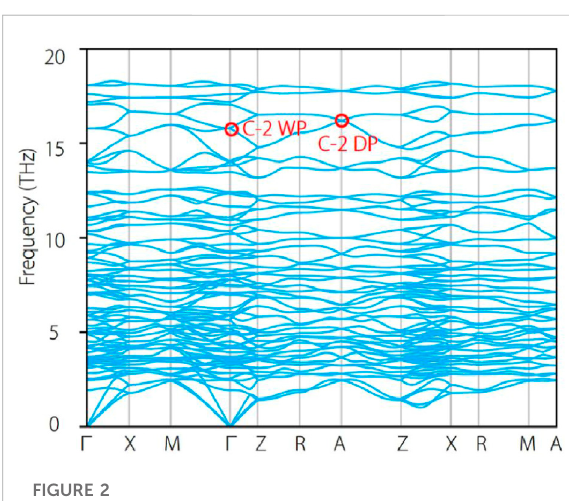
FIGURE 2 PhonondispersionoftetragonalNa 2 Zn 2 O 3 withP4 3 2 1 2along Γ -X-M- Γ -Z-R-A-Z-X-R-M-A high-symmetry paths. The